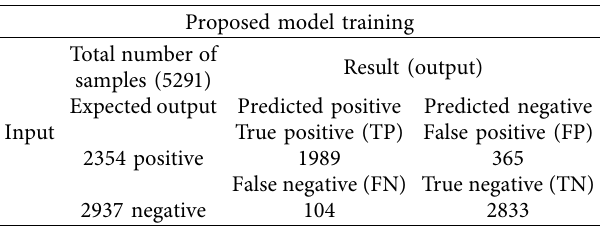
Figure 4: Rule diagram of the proposed 5G congestion control model (no). Table 1: Proposed model training during the prediction of 5G Table 3: Proposed model training during the prediction of 5G congestion (SVM). congestion (Na¨ıve Bayes).